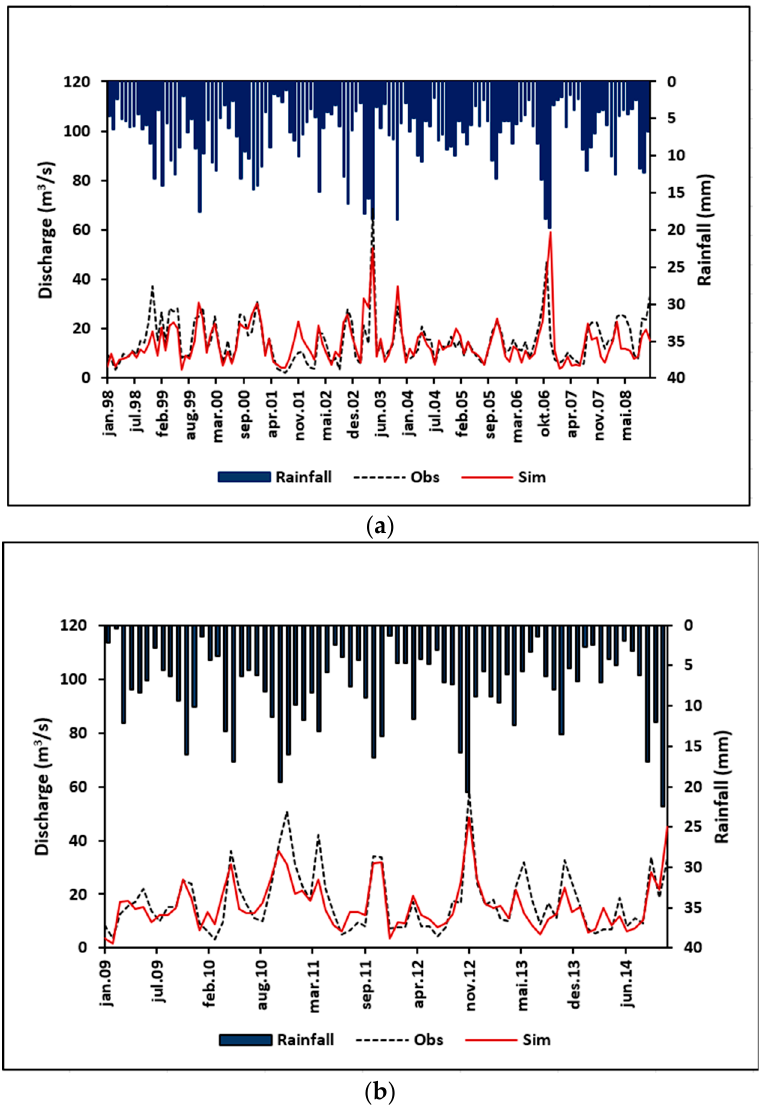
Figure 6. Observed and simulated monthly hydrograph comparison ( a ) for calibration and ( b ) for validation at the Pitabeddara hydrological station.